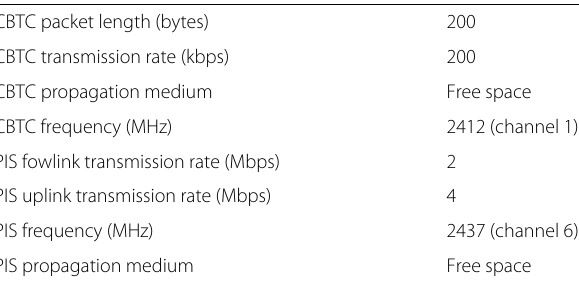
Table 1 Configurations of